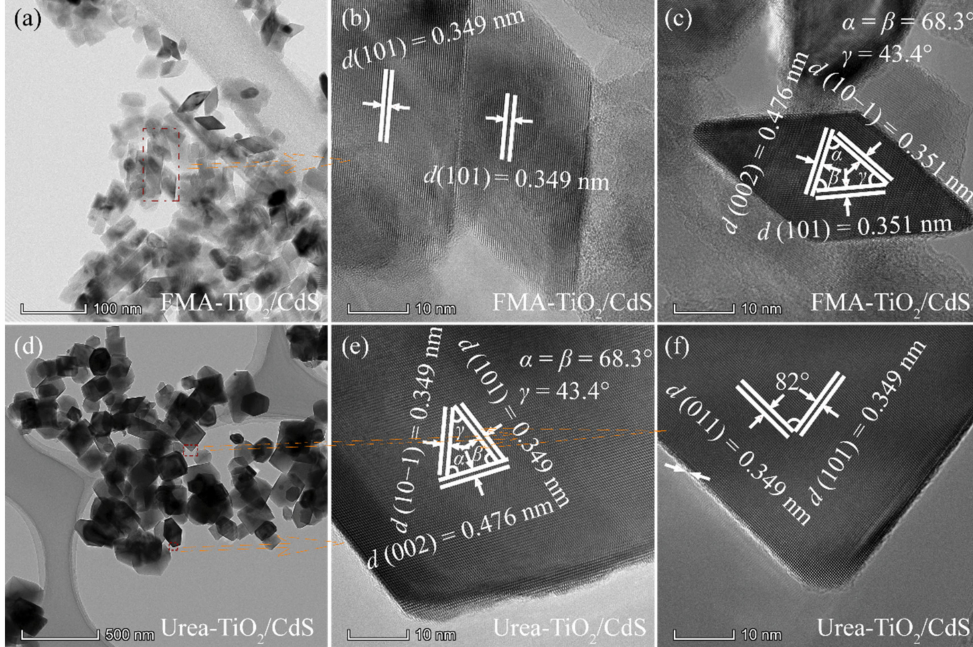
Figure 5. TEM and HRTEM images of ( a – c ) FMA-TiO 2 /CdS, and ( d – f ) Urea-TiO 2 /CdS